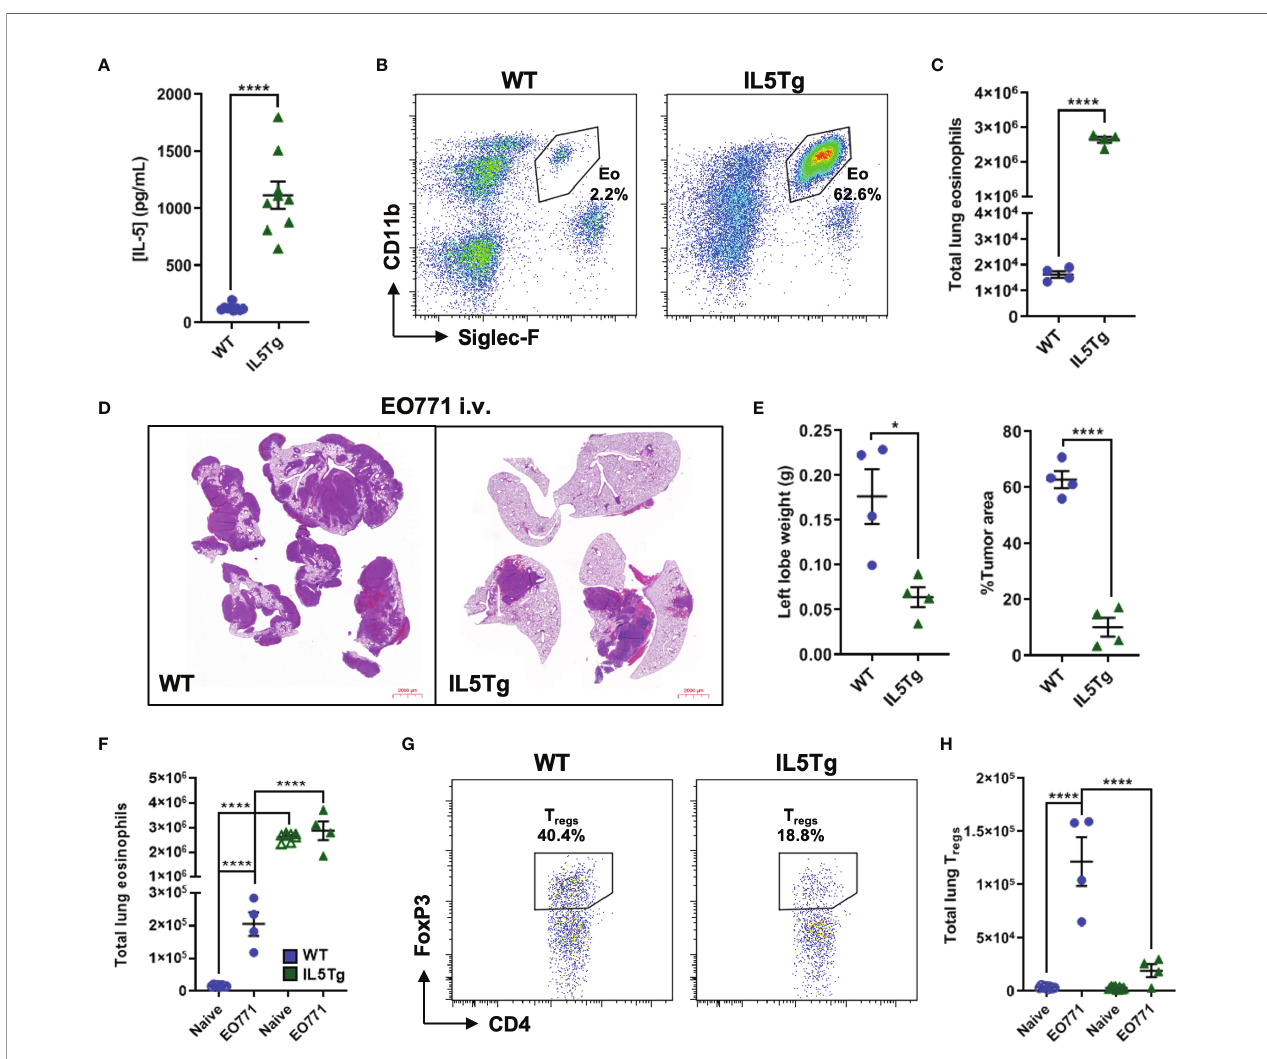
FIGURE 1 | Pulmonary EO771 mammary carcinoma growth is reduced in IL5Tg mice. (A) Quanti fi cation of naïve WT and IL5Tg serum IL-5. (B) Representative fl ow plots of eosinophils (Eo) as a proportion of CD45 + cells in the lungs of naïve WT and IL5Tg mice. (C) Total number of eosinophils in the left lung lobe of naïve WT and IL5Tg mice. (D) Representative images of four right lung lobes harvested from WT and IL5Tg mice 21 days after i.v. injection of EO771 cells. Scale bar = 2000 m m. (E) WT and IL5Tg left lung lobe weights and EO771 tumor area quanti fi cation as a proportion of total area of right lung lobes. (F) Quanti fi cation of eosinophils in the left lung lobe of naïve WT and IL5Tg mice and mice injected i.v. with EO771 cells 21 days post-injection. (G) Representative fl ow plots of T regs as a proportion of CD4 + T cells in the left lung lobe of WT and IL5Tg mice 21 days after i.v. injection of EO771 cells. (H) Number of T regs in the left lung lobe of naïve and EO771 i.v. injected WT and IL5Tg mice. Data points are individual mice with mean ± SEM of 4-8 mice per group. *p < 0.05; ****p <